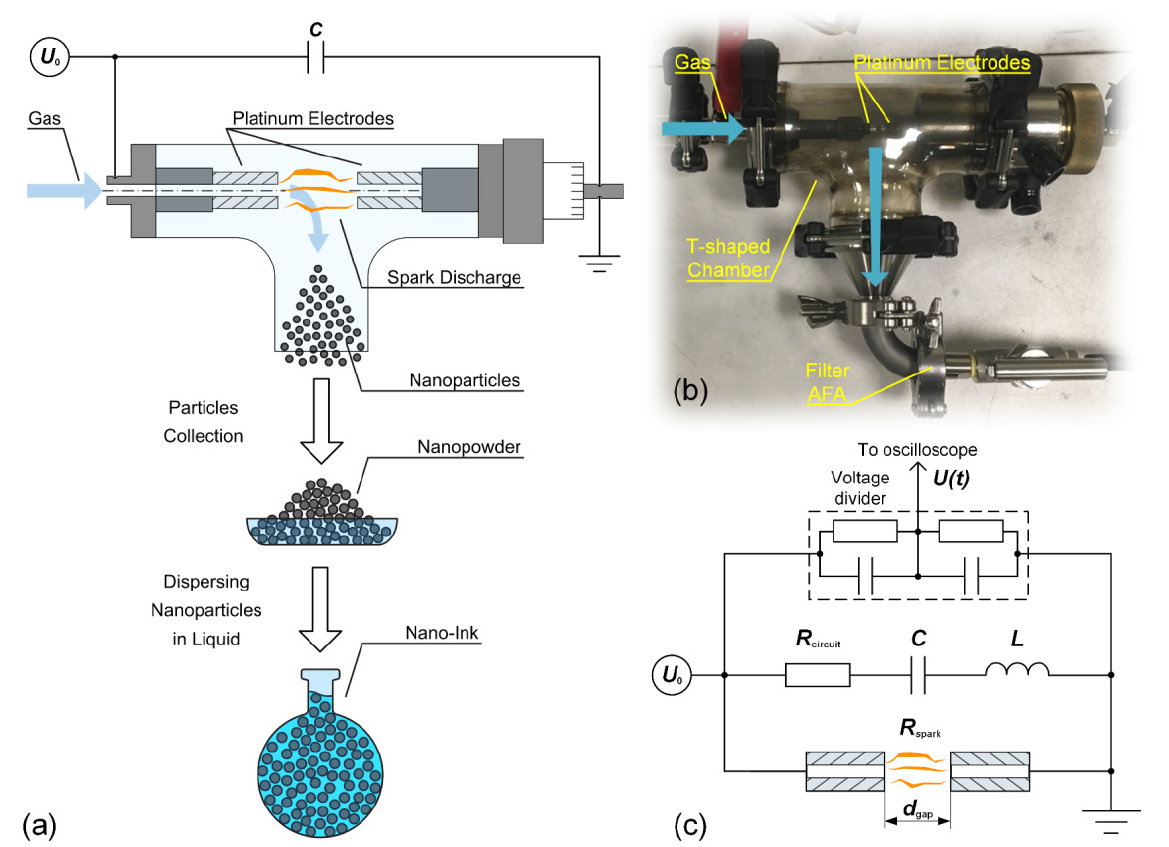
Figure 1. ( a ) Scheme of gas-phase synthesis of nanoparticles for the preparation of platinum nano-ink, ( b ) photograph and ( c ) equivalent electrical circuit of the spark discharge generator (SDG).